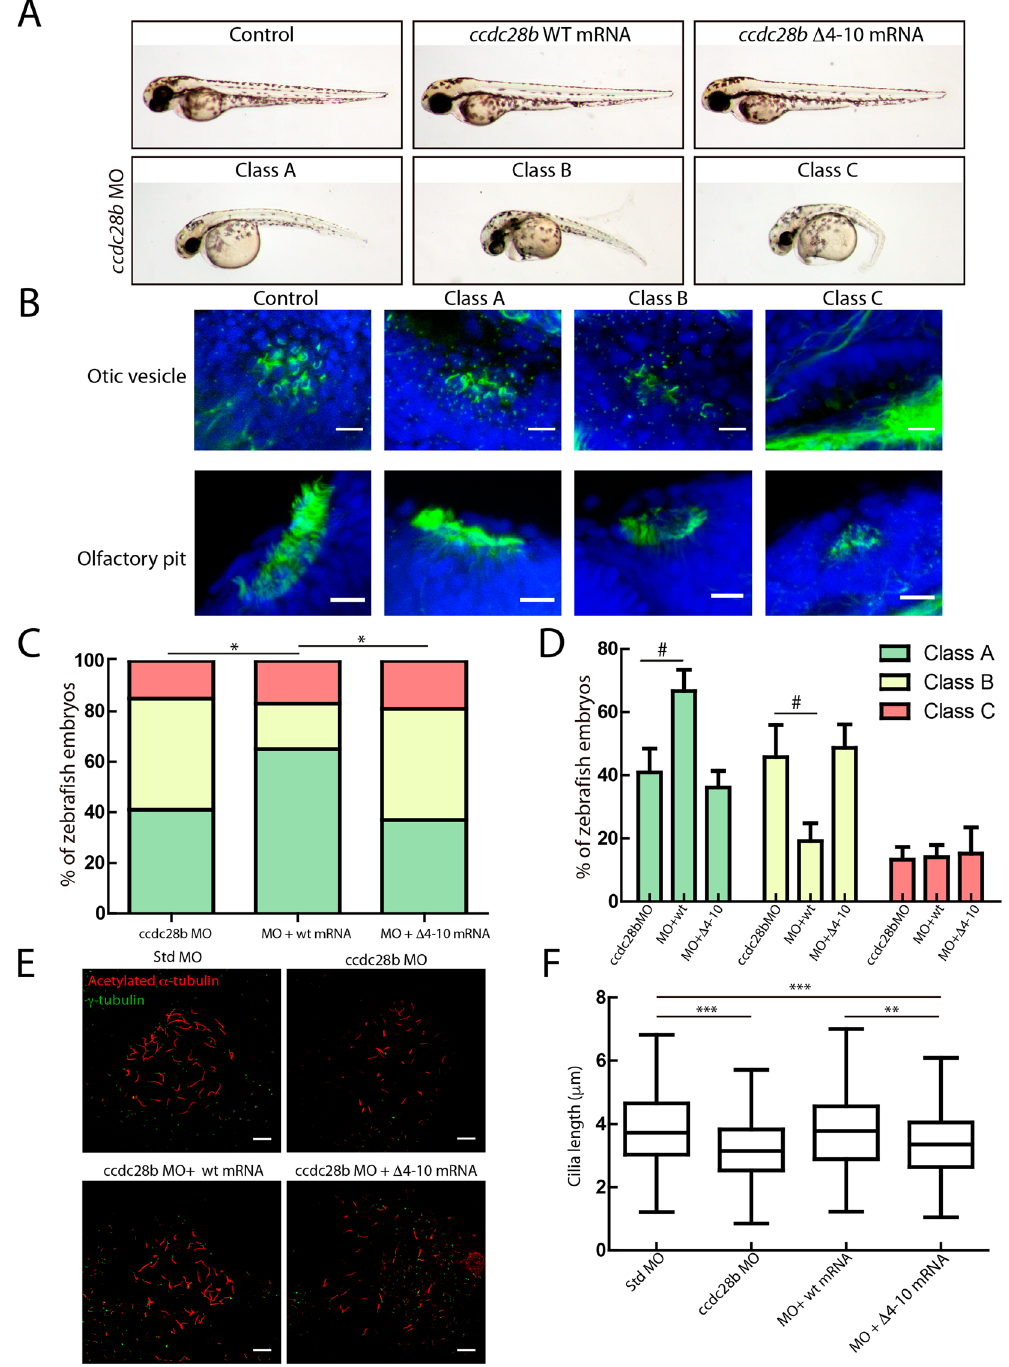
Figure 6. A Δ 4–10 ccdc28b mutant does not rescue the morphant phenotype in zebrafish. ( A ) 48 hpf control and injected zebrafish embryos are shown. While injecting either wt or mutant ccdc28b mRNA does not result in phenotypic alterations, injection of the ccdc28b MO results in a range of phenotypes from mild to severe corresponding to Class A to C respectively. Representative images of each class are shown. ( B ) The severity of the external morphological phenotype in the different classes correlates with an increasing perturbation of ciliated tissues. Otic vesicle and nasal pit are shown. ( C ) The class distribution upon injection of morpholino alone ( ccdc28b MO) and morpholino co-injected with either wt or Δ 4–10 mutant ccdc28b mRNA was compared. Data from five independent injections were pooled reaching 128 ccdc28b MO, 65 ccdc28b MO + wt mRNA and 63 ccdc28b MO + Δ 4–10 ccdc28b mRNA embryos. A rescue of the phenotype was observed only upon injecting the wt mRNA but not the Δ 4–10 mutant. Statistical test: χ 2 ; * P < 0.01. ( D ) The percentage of embryos in each phenotypic class was calculated for the five individual experiments. The mean and SEM (bars) are plotted. The differences between conditions (#) were analyzed using the Wilcoxon rank test ( P = 0.06